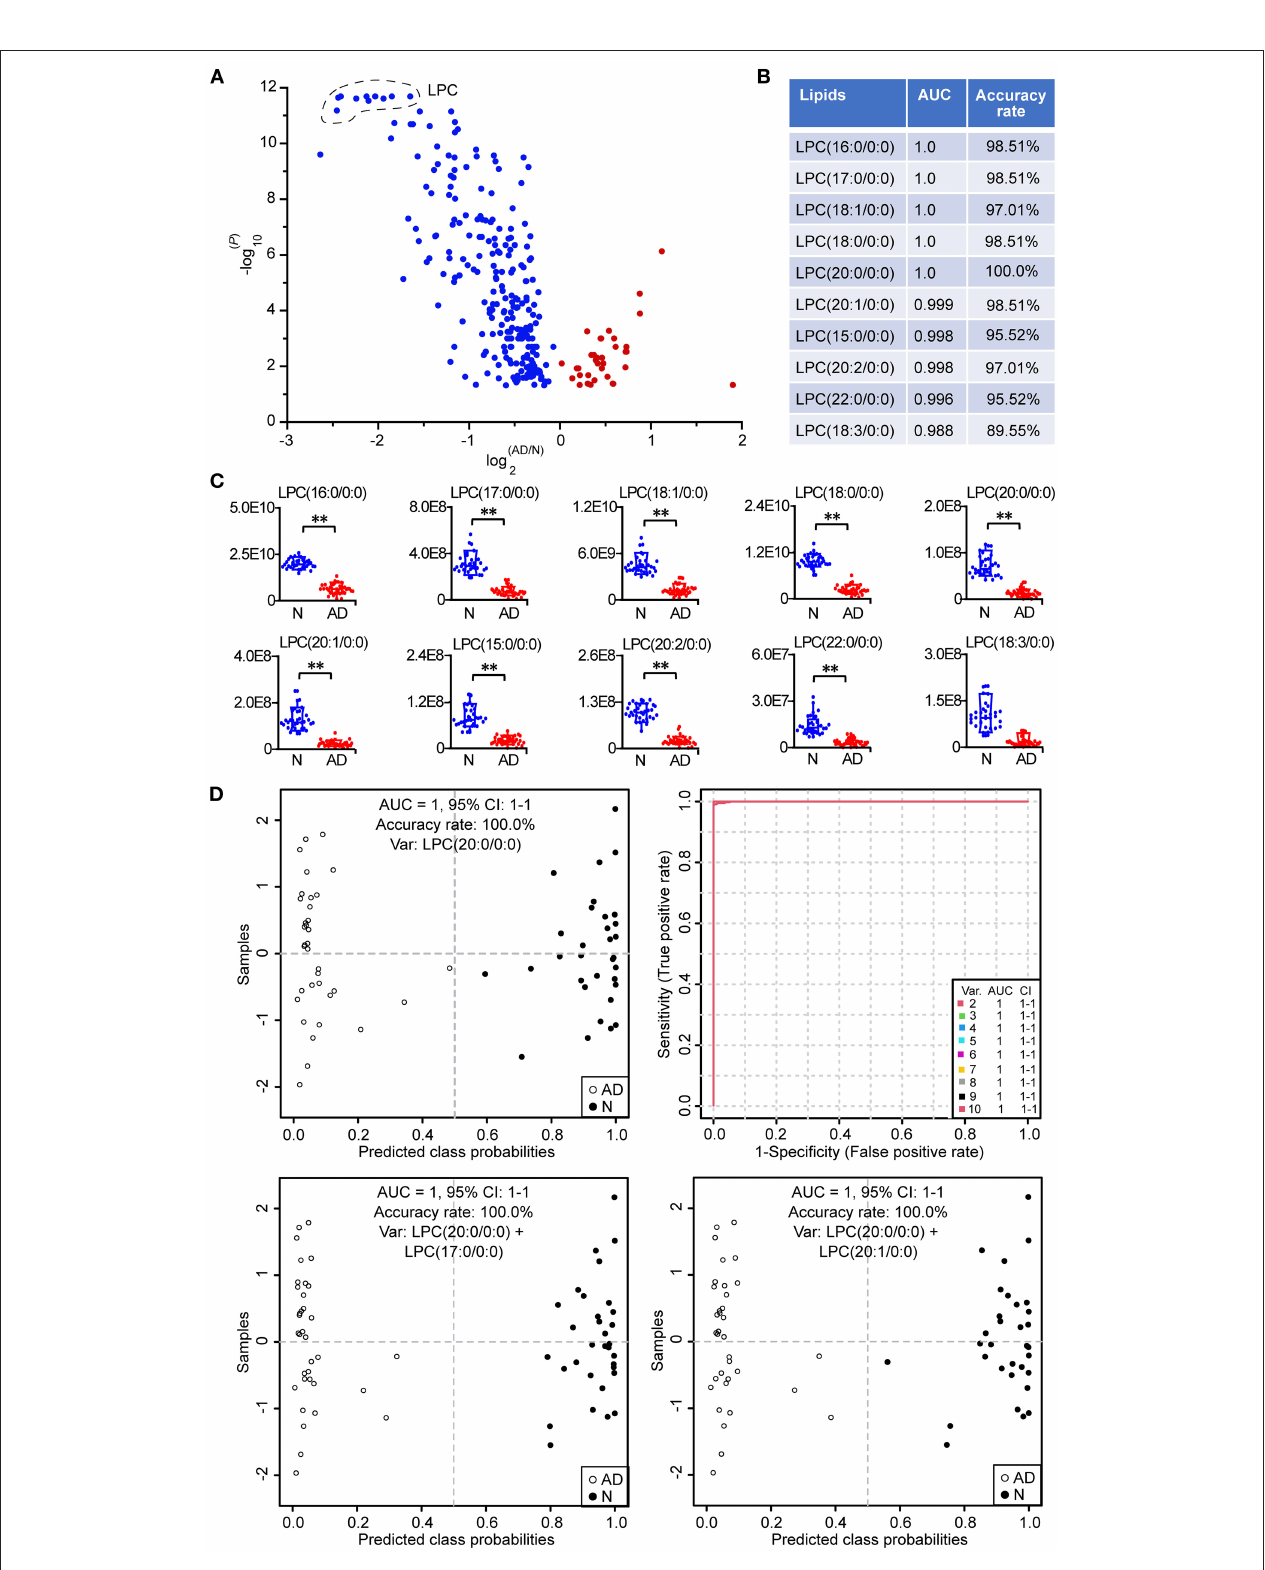
FIGURE 7 | Potential biomarkers for the identification of patients with AD. (A) Volcano plot of lipid alterations. Only the differential lipids ( P < 0.05, two-tailed Mann-Whitney U test) are shown in the plot. (B) Classical univariate ROC (receiver operating characteristic) curve analyses of the top 10 lipids with the lowest P -value. (C) Box plot of the top 10 lipids with the lowest P -value. The relative abundances of lipids were used. ** P < 0.01, two-tailed Mann-Whitney U test. (D) Discovery of important potential biomarkers by